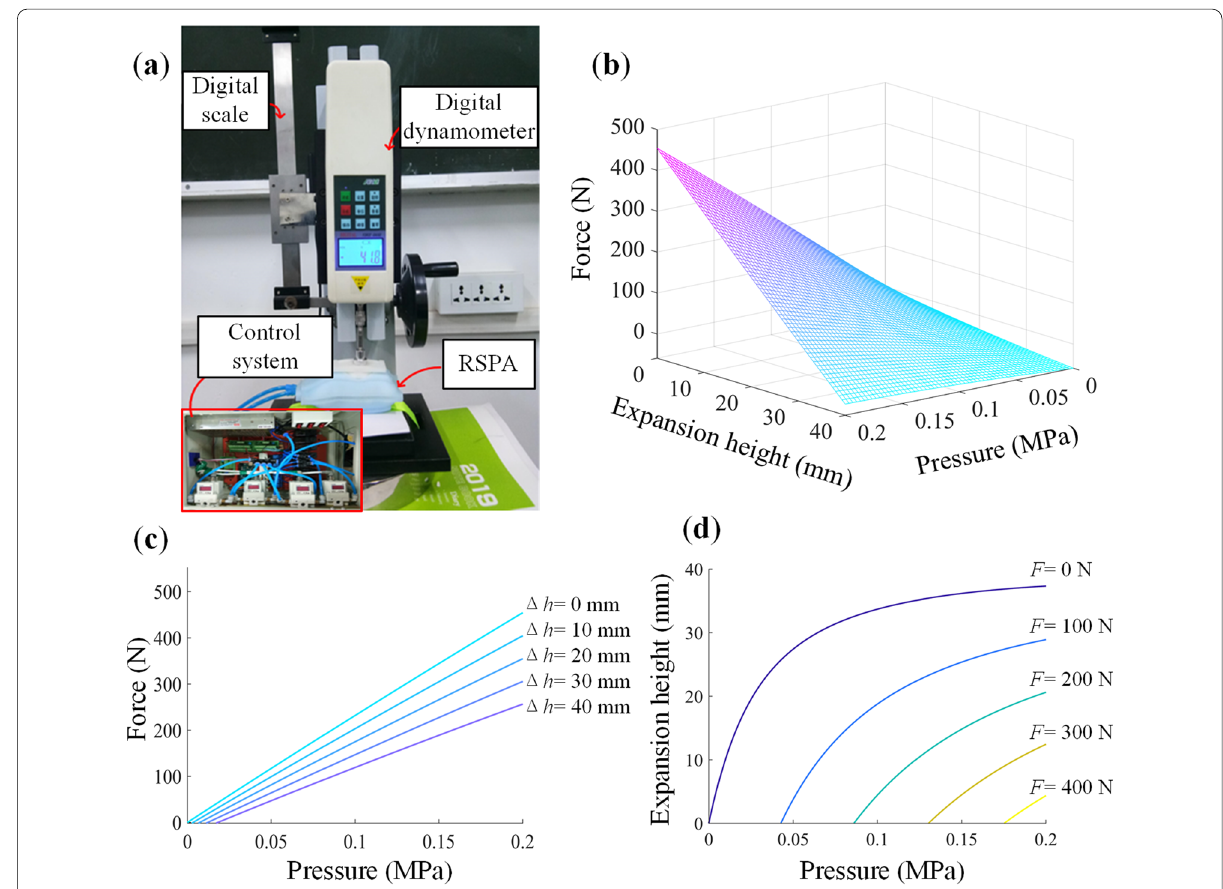
Figure 5 Output characteristics of the RSPA: ( a ) Test system for the RSPA, ( b ) The performance parameter relationships between output force, expansion height and pressure of the RSPA, ( c ) The relationship between output force and pressure of the RSPA at different expansion heights, ( d ) The relationship between expansion height and pressure of the RSPA at different output forces